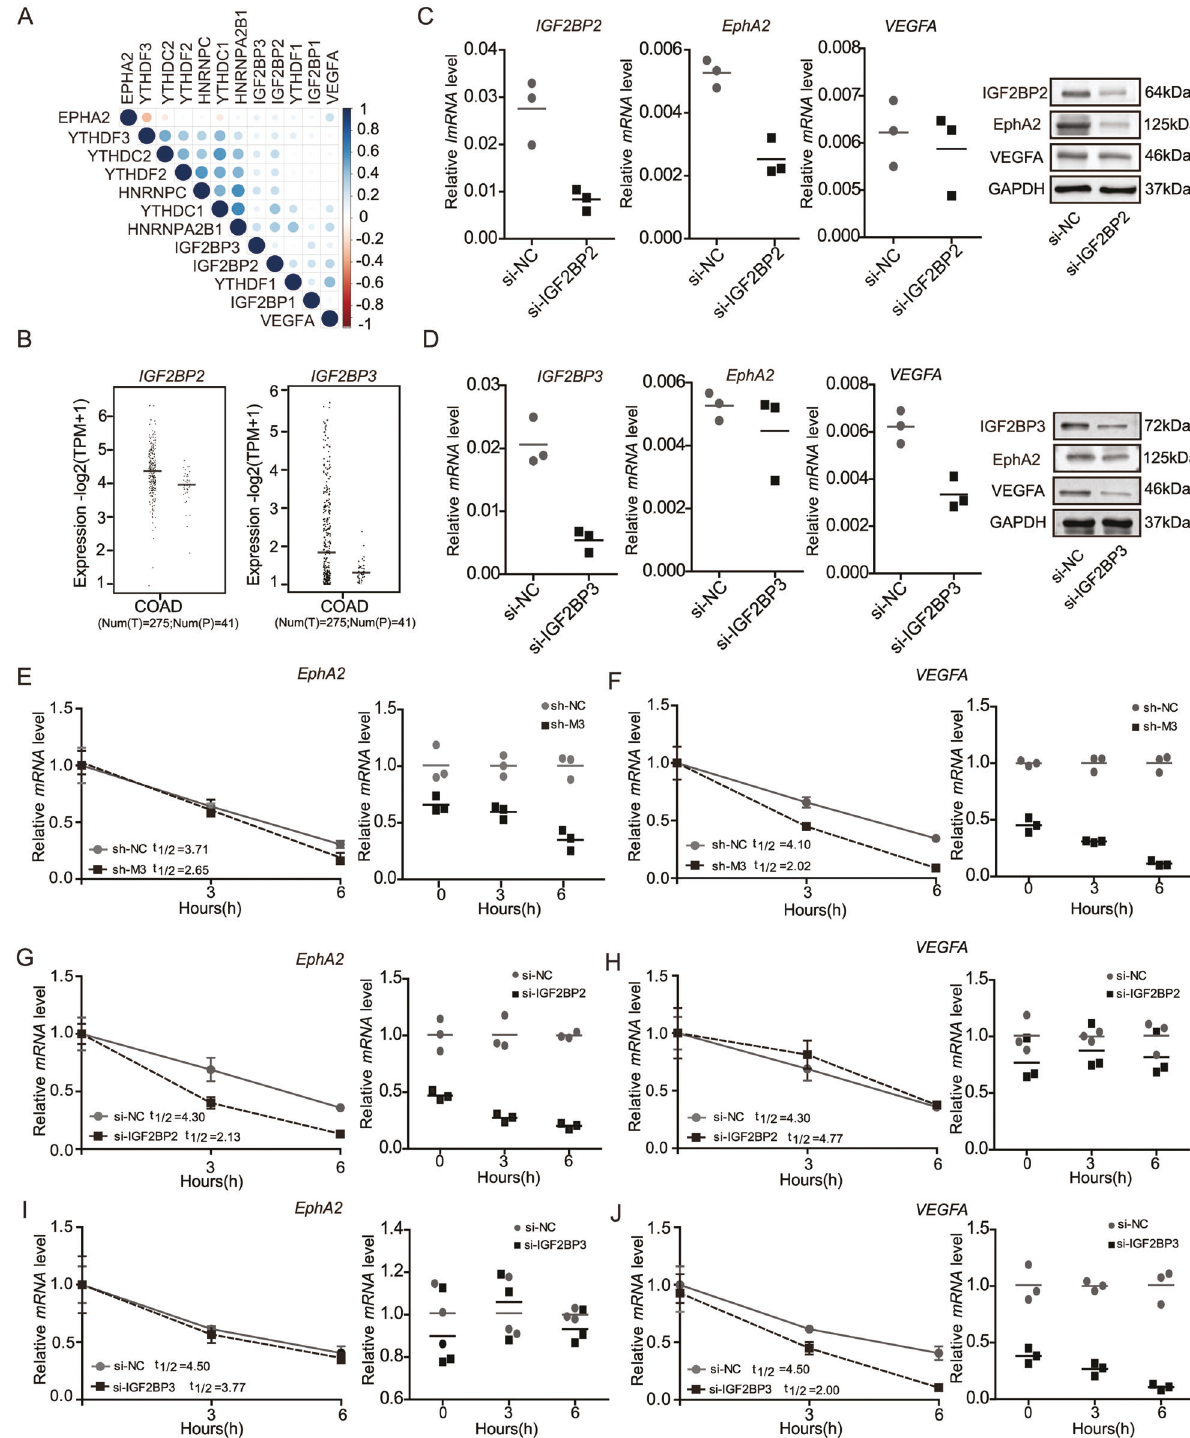
Fig. 4 METTL3 knockdown enhances EphA2 and VEGFA mRNA stability via an m6A-IGF2BP2/3-dependent pathway. A The association of EphA2/VEGFA and m6A readers in colon cancer analyzed based on TCGA database. B The mRNA expression of IGF2BP2/3 in colon cancer analyzed using the GEPIA website tool based on TCGA. C , D Real-time PCR and western blot assay of EphA2 and VEGFA expression in HCT116 cells after depletion of m6A readers (IGF2BP2/3). E , F The decay rate of mRNA and qPCR analysis of EphA2 and VEGFA at the indicated times after actinomycin D (5 μ g/ml) treatment in HCT116 cells after METTL3 inhibition. G – J The decay rate of mRNA and qPCR analysis of EphA2 and VEGFA at the indicated times after actinomycin D (5 μ g/ml) treatment in HCT116 cells after IGF2BP2/3 inhibition. p values were calculated using the t test from three independent experiments. * p < 0.05, ** p < 0.01 (Student ’ s t test).